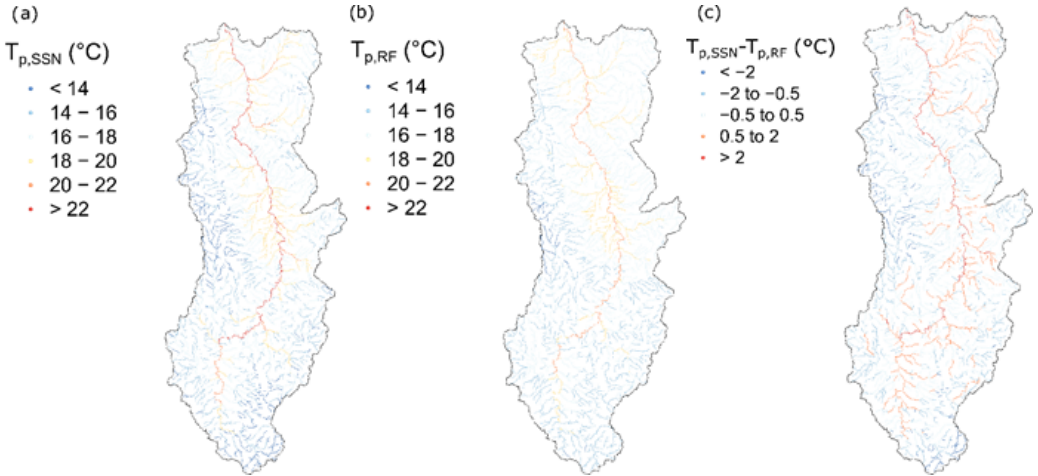
Figure B5. Figure comparing modeled thermal peak ( T p , m ) estimates from (a) SSN, (b) RF, and (c) the difference between RF and SSN. The SSN model here is from a benchmark test on a small region well covered by data (9000km 2 , 92 stations) for a robust estimation of parameters with the R package “SSN”. SSN had reduced bias relative to that of the random forest model (absolute bias decreased by 0.2 ◦ C). Additionally, by comparing the observed and estimated values, we can see that RF tends to underestimate the high values and to overestimate the low values. Unfortunately, due to the lack of an RHT with upstream–downstream information, we could not apply at the scale of the whole watershed. Still, the spatial patterns are very consistent among the two approaches, though there are important differences between the SSN and RF model estimates which can be ± 2 ◦ C. The estimates of the SSN model are generally warmer than those of RF on the main major river axes and colder on the small tributaries. This is also consistent with observations. So, while the presented models may not be optimal, we are confident the spatial patterns are